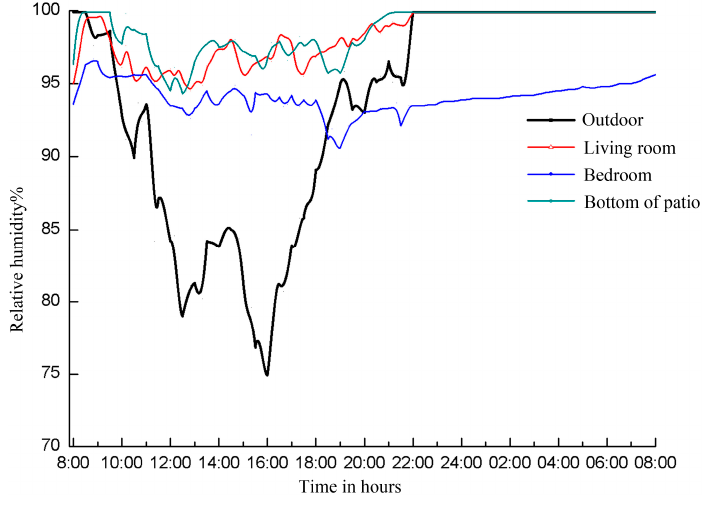
Figure 5. Comparison of relative humidity.